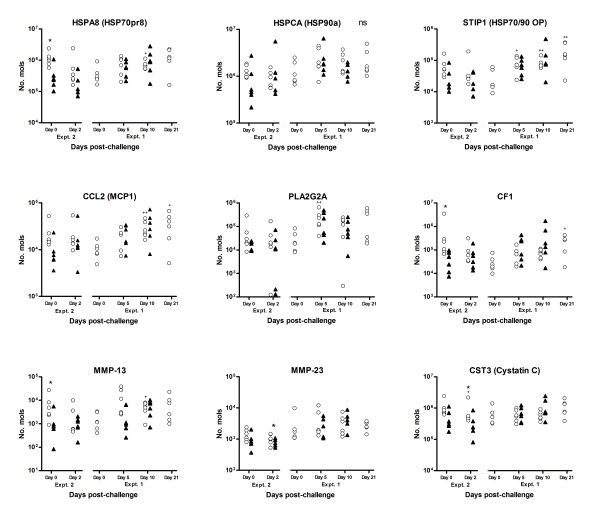
Results of competitive multiplex qRT-PCR analysis to investigate temporal changes in the expression levels of a number of transcripts associated with tissue remodelling or inflammatory responses throughout the experiment trials summarised in Table 1. Data is shown for heat shock proteins HSPA8, HSPCA and STIP1; transcripts associated with pro-inflammatory responses CCL2, PLA2G2A and CF1, and matrix metalloproteinases and inhibitors MMP-13, MMP-23 and cystatin C, as indicated. Open circles represent data from naïve sheep; closed triangles represent data from immune ("previously infected") sheep. Significant difference between Nv and Im at same timepoint; *P ≤ 0.05, **P ≤ 0.005, ***P ≤ 0.005; Significant difference between timepoint and day 0 of same group (where available); +P ≤ 0.05, ++P ≤ 0.005, +++P ≤ 0.005 (Mann-Whitney U-test for non-parametric data).